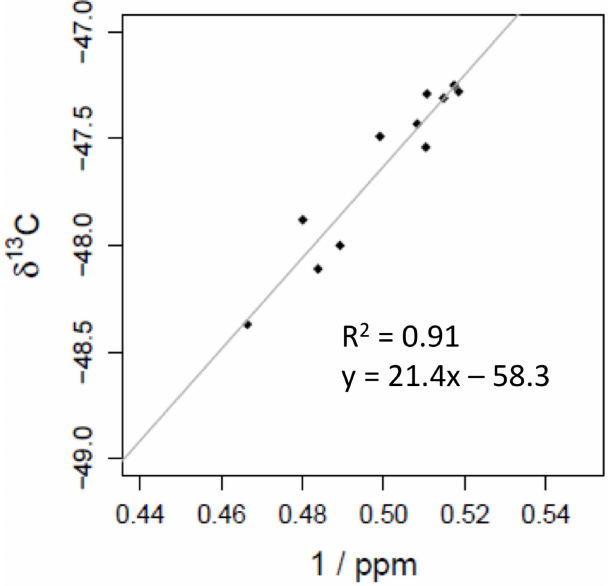
Figure 3. Keeling plot of the air samples taken at Haddenham church between 06:00 and 14:00UTC on 11 February